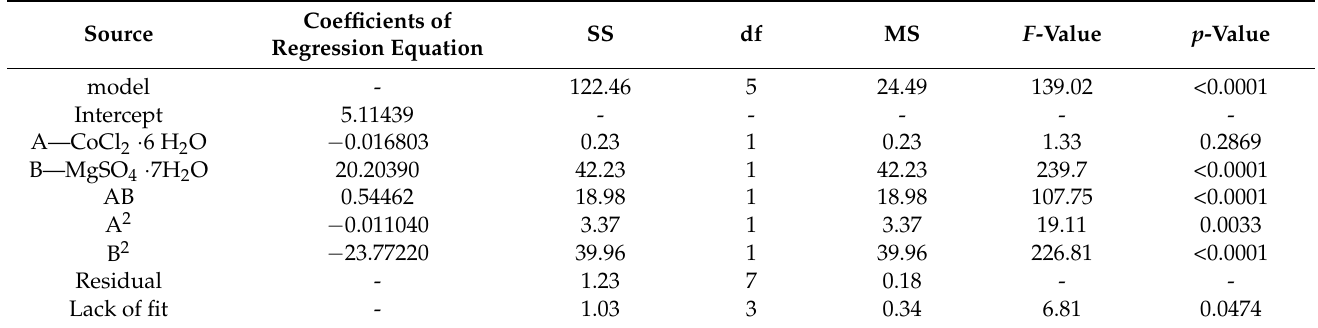
Table 6. Statistical analysis results according to ANOVA for the central composite